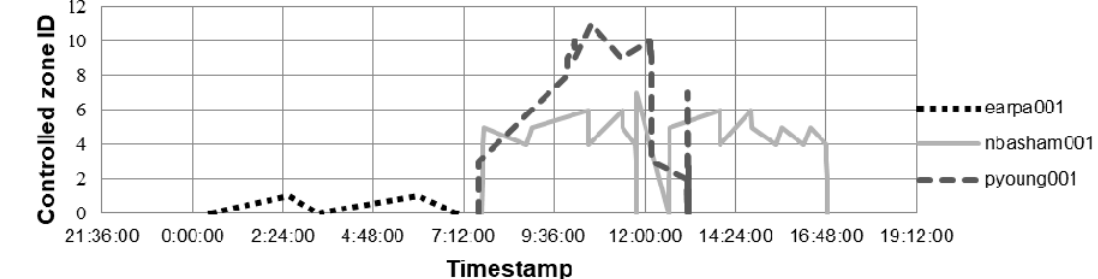
Figure 2. The representation of the proximity switch logs as time series.